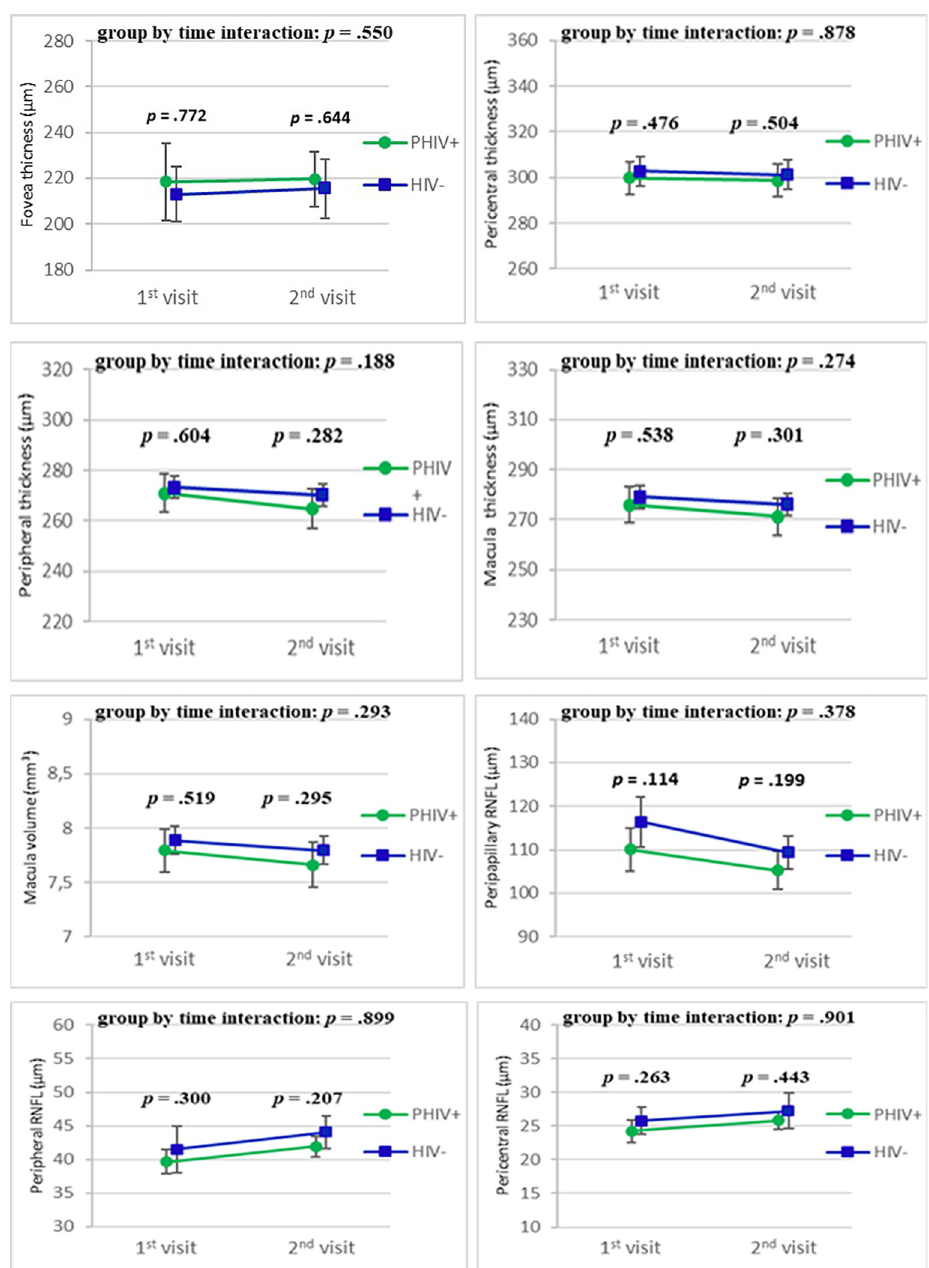
Fig 3. Longitudinal changes over time in retina thickness and volume in PHIV children and healthy controls. The figure shows changes between the first and follow-up OCT measurements in HIV-infected children (PHIV + in green) and healthy controls (HIV- in blue). The graphs show the means with the 95% confidence interval and p-values of the group-by-time interaction and at both visits using linear (mixed) regression model adjusted for sex and age; RNFL = retina nerve fibre